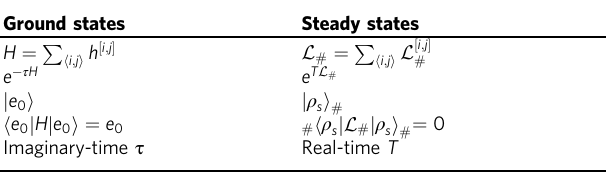
Table 1 Parallelism between the calculation of ground states by imaginary time evolution, and the calculation of steady states by real-time evolution Ground